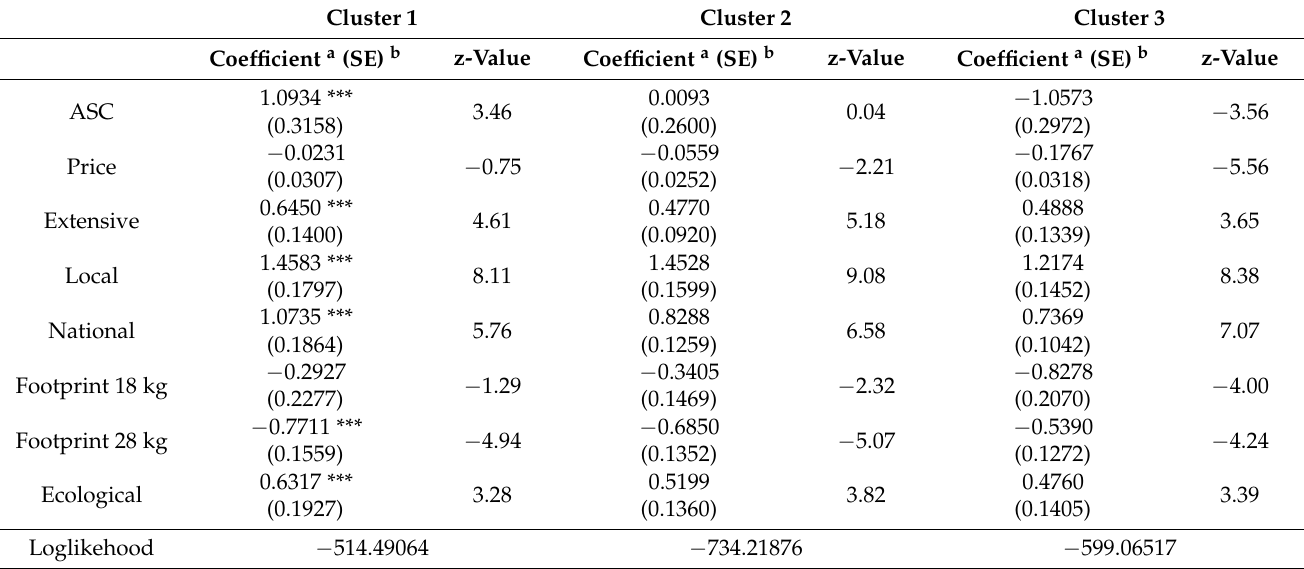
Table 6. Results from the logit model (Choice experiment) for the various